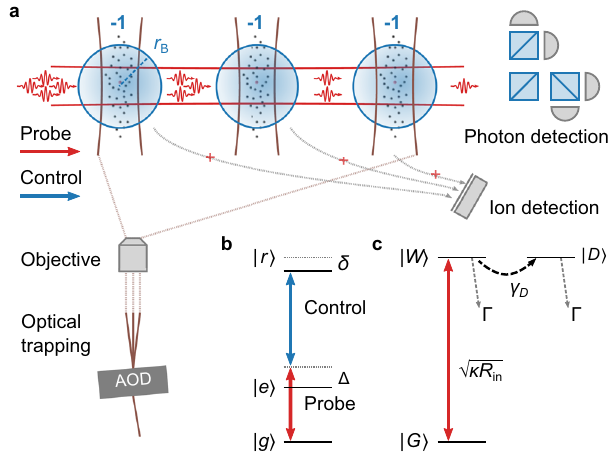
Fig. 1 Realisation of up to three cascaded single-photon absorbers using Rydberg superatoms. a To create n sub saturable superatom absorbers, we place n sub ensembles of cold 87 Rb atoms in the path of a tightly focussed probe beam. Using an acousto-optical de fl ector (AOD), we can control the number and position of the optical traps that tightly con fi ne the ensembles below the Rydberg blockade radius r B along the probe direction. b Within r B strong van der Waals interactions restrict each ensemble to a single Rydberg excitation as the probe photons and a control fi eld couple j g i ¼ j 5 P 3 = 2 ; F ¼ 3 ; m F ¼ 3 i in a Raman scheme with detuning Δ /2 π ≈ 100 MHz and thus to the absorption of a single photon at a time for a two-photon detuning of δ = 0. The transmitted probe pulses are coupled into a single- mode optical fi bre (not shown) and detected on four single-photon counters in a Hanbury-Brown-Twiss con fi guration. c Representation of the absorber as an effective three-level system in terms of singly excited collective states following adiabatic elimination of j e i . Strong dephasing γ D p ffiffiffiffiffiffiffiffi κ R from the from the bright excited state j W i , with strong coupling in ground state j G i , into dark excited states j D i prevents stimulated re- emission of the absorbed photon and the absorption of further photons until it is subject to Raman decay Γ ≪ γ D , κ